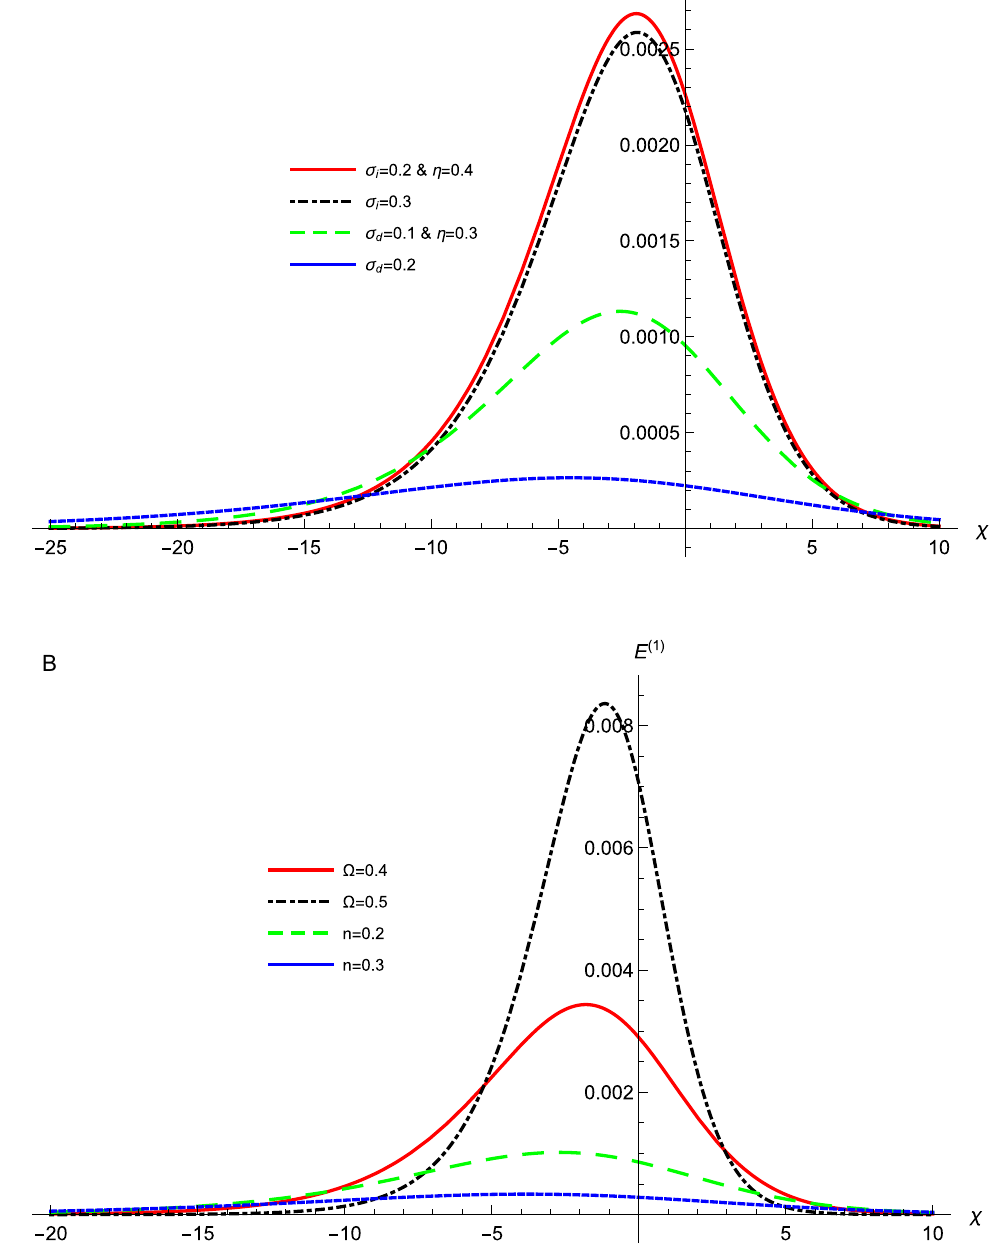
Figure 4. The evolution of the associated electric field, E ( the potentials those represented by Fig. 1, for different values of ( a ) σ i , σ d , and η with n = 0.3 , and (cid:31) = 0.4 , ( b ) n , and (cid:31) = with σ i = 0.2 , σ d = 0.1 , and η = 0.3